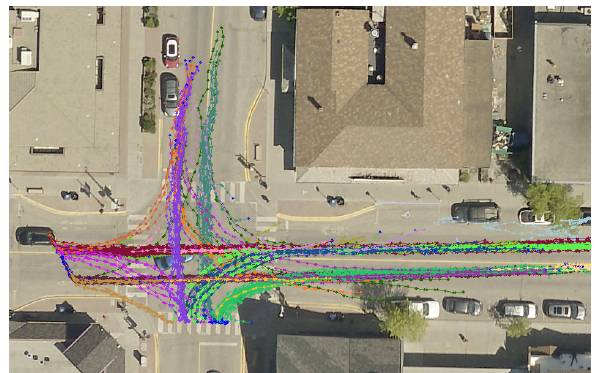
Figure 13. Vehicle trajectory clusters